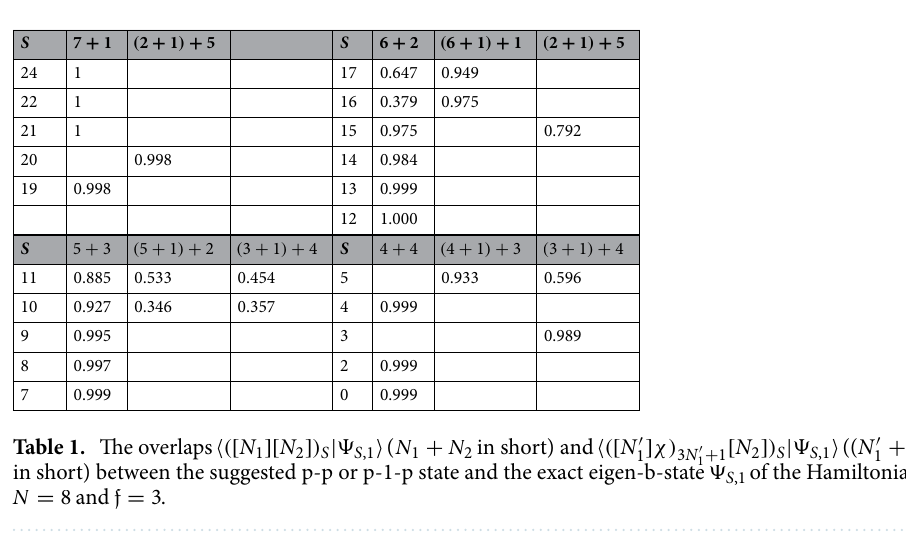
Figure 1. The complete spectrum of an 8-body system with spin-3 trapped cold atoms and with the Hamiltonian H (cid:31) . The unit for energy is ( g 0 − g 6 )/ 2 . Totally there are 151 states (levels). The abscissa is for the excitation energies E X from 0 (the g.s.) to 45.68 (the highest energy state). The ordinate is for the total spin S of each state. The S -group of states are lying along a short horizontal dot-line. E X of the b-state and the t-state are marked by a red circle and a blue triangle, respectively. The multiplicity of an S -group is marked at the right of the dot-line if it ≥ 3 . When multiplicity = 1 , only a red circle is marked for the E X of the state. For an example, the group with S = 15 contains 5 states and E X is distributed from 23.42 to 30.75.